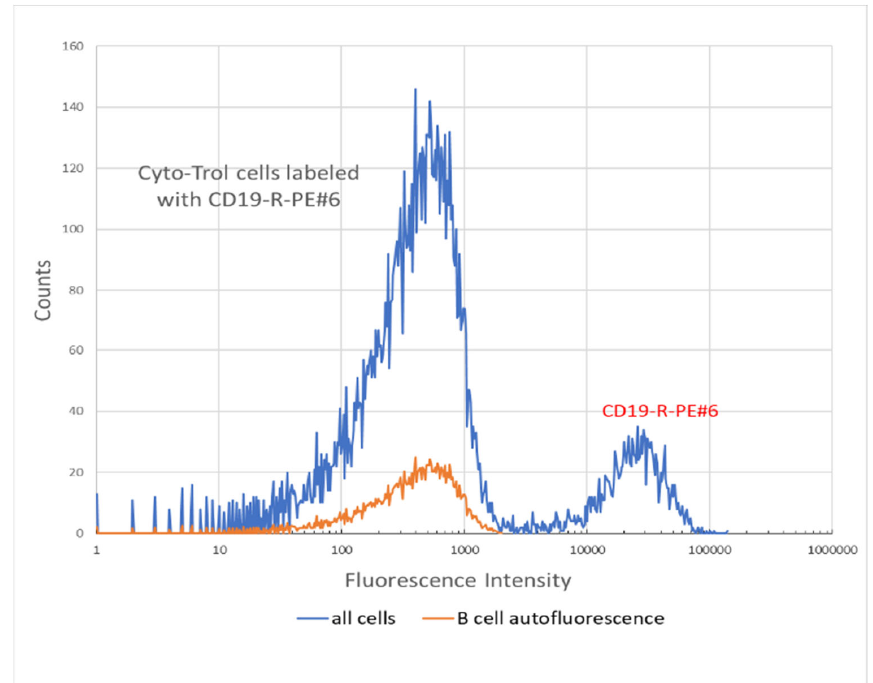
Figure 8. Histogram of fluorescence signal from a sample of PBMC labeled with CD19-R-PE #6. The orange trace is an estimate of the autofluorescence from B cells alone. The horizontal axis gives the fluorescence intensity in digital units.